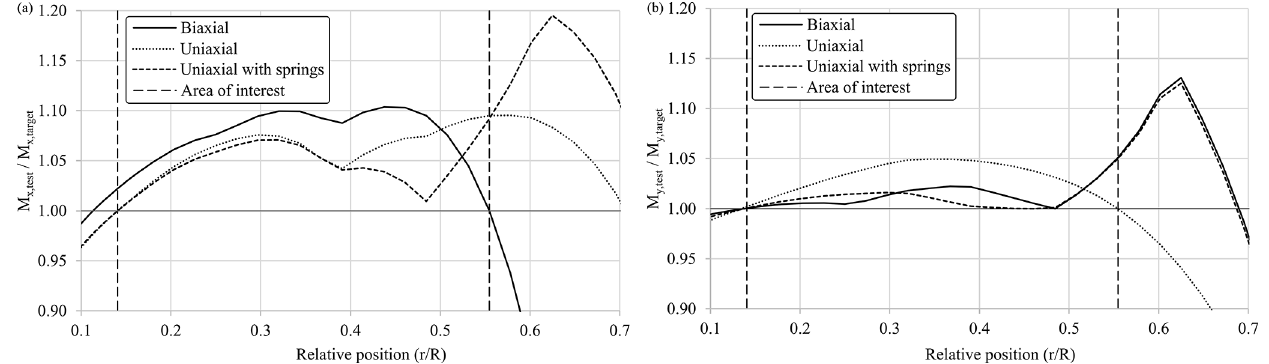
Figure 8. Test load distribution relative to target load for different test setups in flapwise (a) and lead-lag (b) directions.